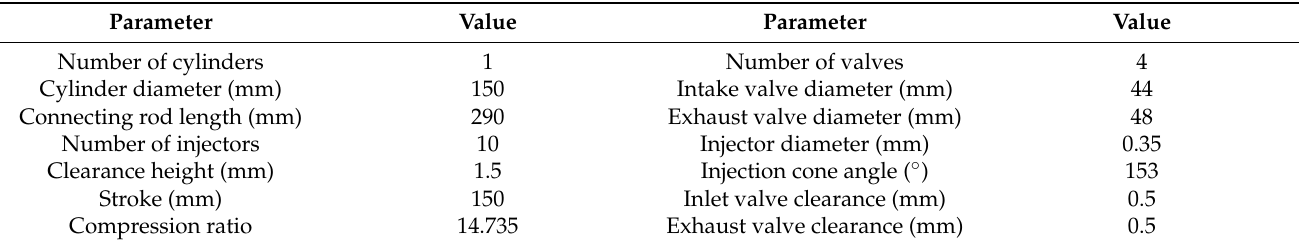
Table 5. Key parameters of engine computer aided engineering